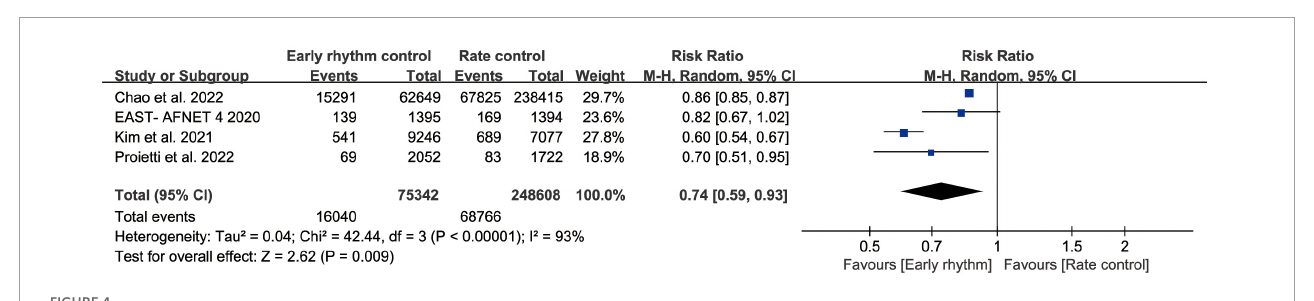
FIGURE4 Forest plot showing risk of heart failure hospitalization between early rhythm group and rate group.